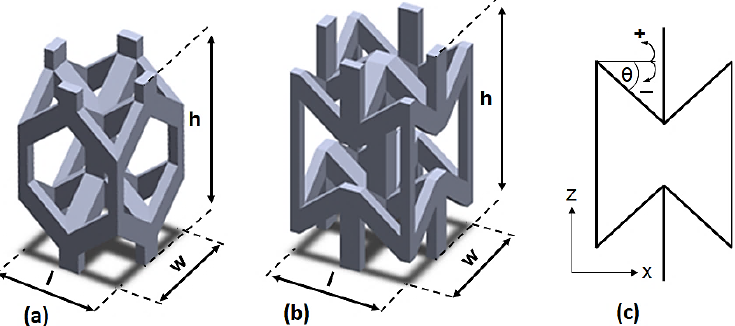
Figure 2. The 3D CAD models of the basic unit cells: ( a ) HU; ( b ) RU, and ( c ) the 2D representation of the re-entrant unit cell.